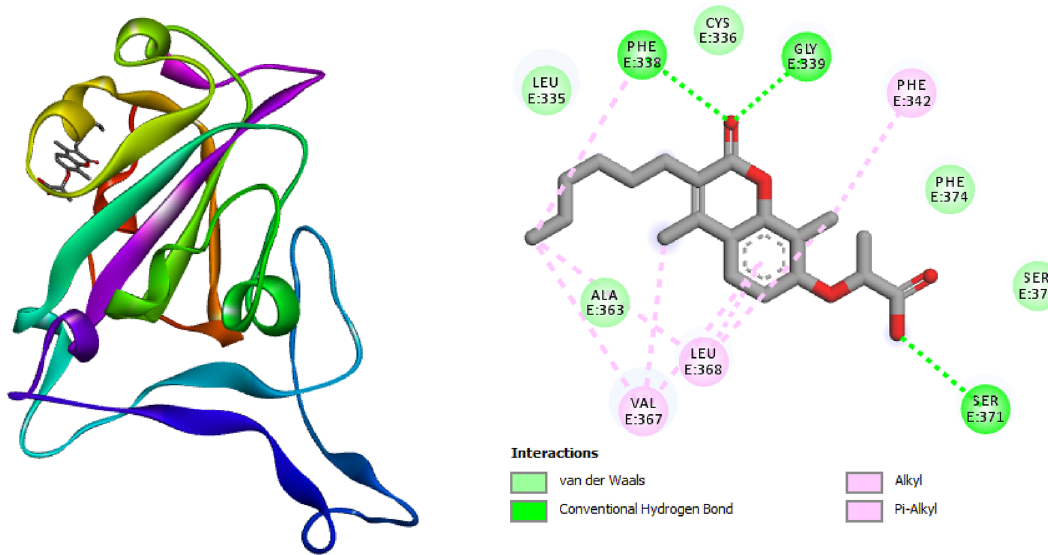
Figure 4. Three dimension (3D) structure of ( A ) Compound 5 in complex with SARS-CoV-2 protein (highest binding energy) ( B ) 2-D representations of docked complex of Compound 5 in complex SARS-CoV-2 protein displaying the interactions with amino acid residues.